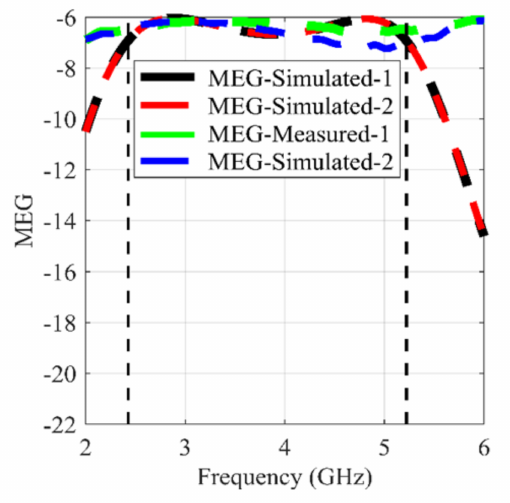
Figure 20. The measured and simulated MEG for mid-band MIMO configuration.